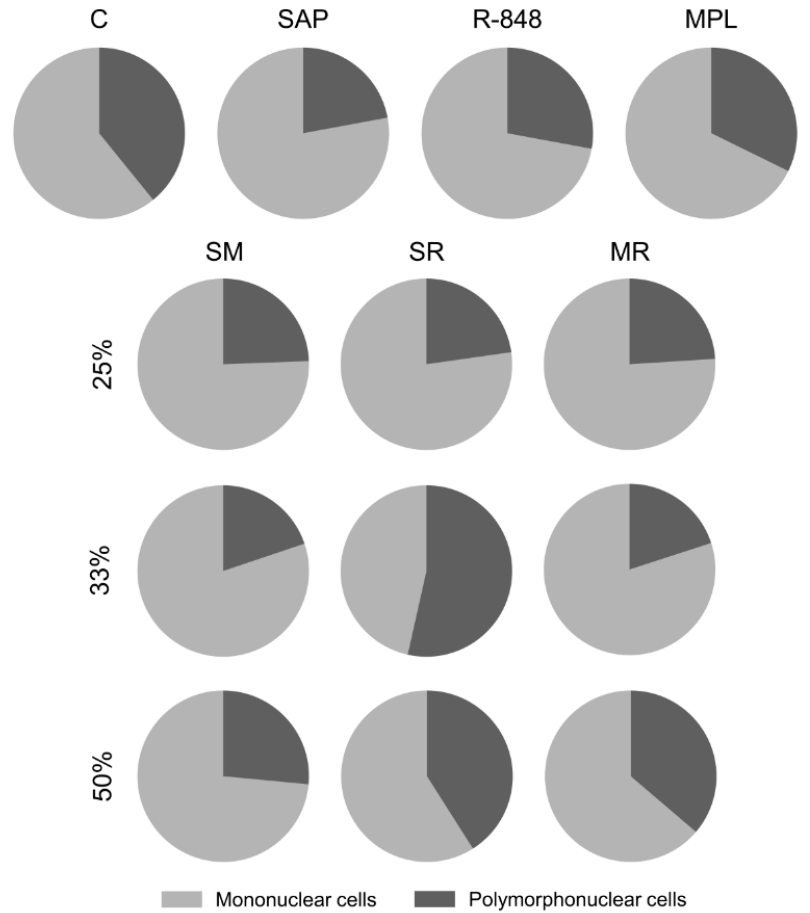
Figure 2. Differential leukocyte count in the BALB/c mouse skin 48 h after sensitization with the adjuvants isolated or combined into adjuvant systems ( n = 12/group). Percentage values of mononuclear (light gray) and polymorphonuclear (dark gray) cells were displayed on pie charts.